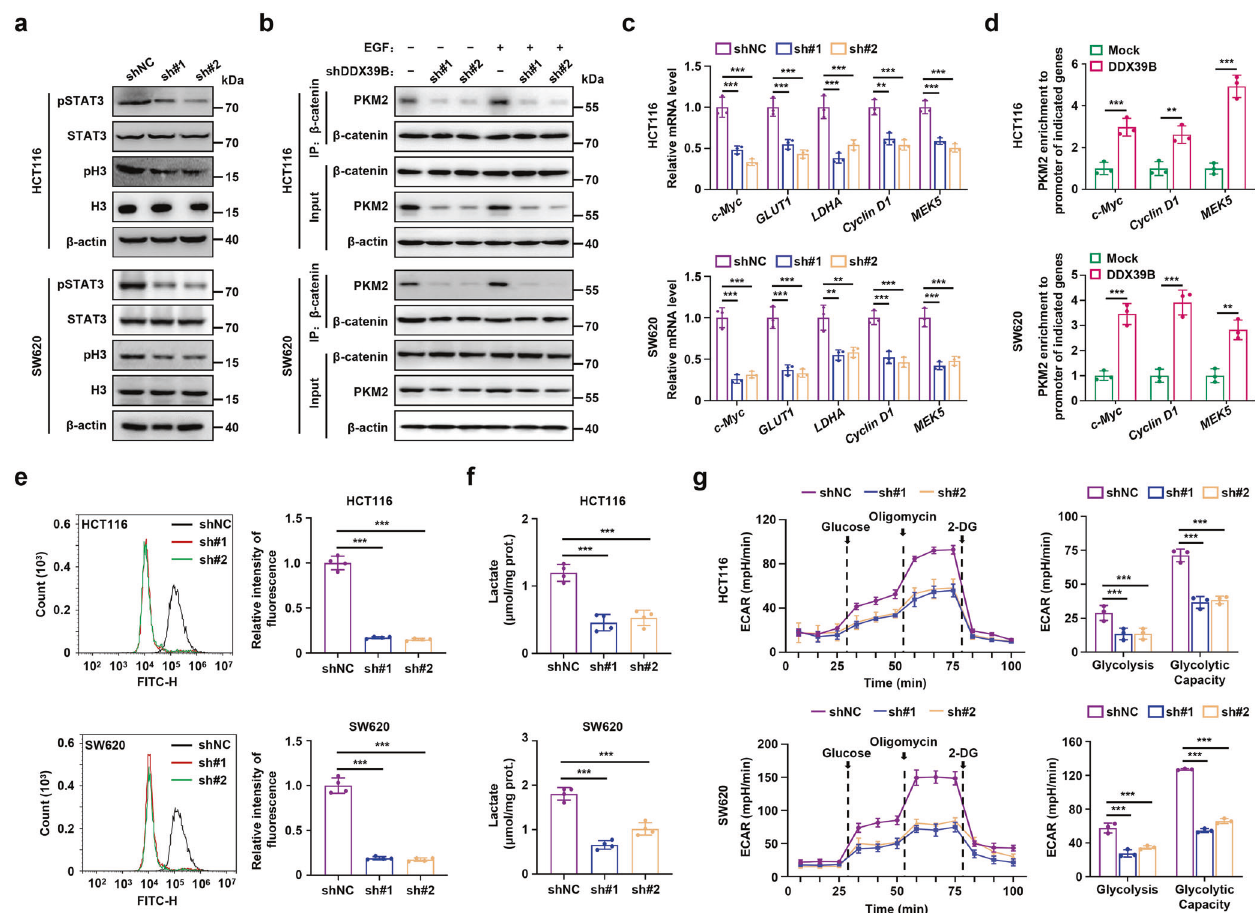
Fig. 6 DDX39B enhances nuclear PKM2 function and aerobic glycolysis in CRC cells. a Phosphorylation of STAT3 Y705 and histone H3 T11 in DDX39B-knockdown CRC cells was detected by western blotting. b DDX39B-de fi cient CRC cells were treated with or without 150 ng/ml EGF, and the association of PKM2 with β -catenin was detected by immunoprecipitation assay. c The relative mRNA levels of c-Myc, GLUT1, LDHA, Cyclin D1, and MEK5 were measured by qPCR in CRC cells stably expressing shNC or shDDX39B. d Binding of PKM2 to the promoters of c-Myc, Cyclin D1, and MEK5 was detected by chromatin immunoprecipitation analysis. e Glucose uptake in DDX39B-knockdown CRC cells was detected by fl ow cytometry using the fl uorescent glucose analog 2-NBDG. f The lactate levels in DDX39B-de fi cient CRC cells were quanti fi ed. g The extracellular acidi fi cation rate (ECAR) of DDX39B-knockdown CRC cells was monitored, and the levels of glycolysis and glycolytic capacity were calculated. Data are presented as mean ± SD. The p values were determined by Student ’ s t test ( d ) or one-way ANOVA (others). ** p < 0.01, *** p <